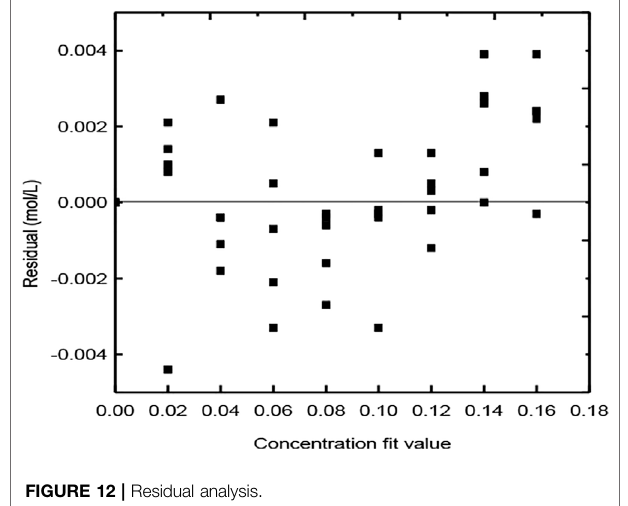
FIGURE 12 | Residual analysis.